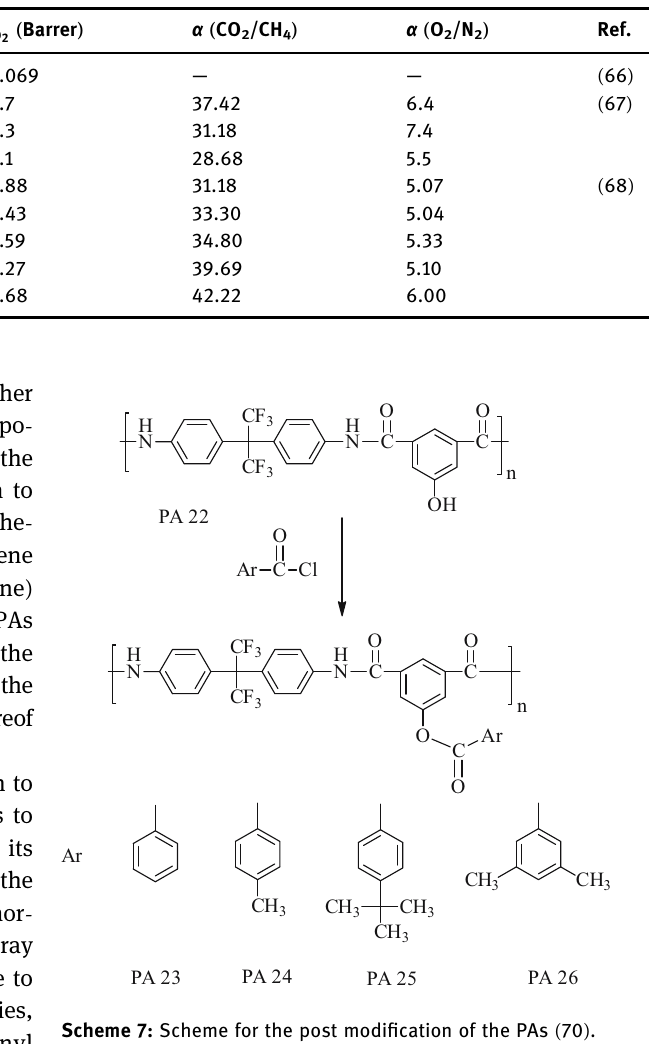
Table 7: Gas permeability ( in Barrers ) and permselectivity values of the copolyaramids having bulky groups at 2 atm upstream pressure and 35°C